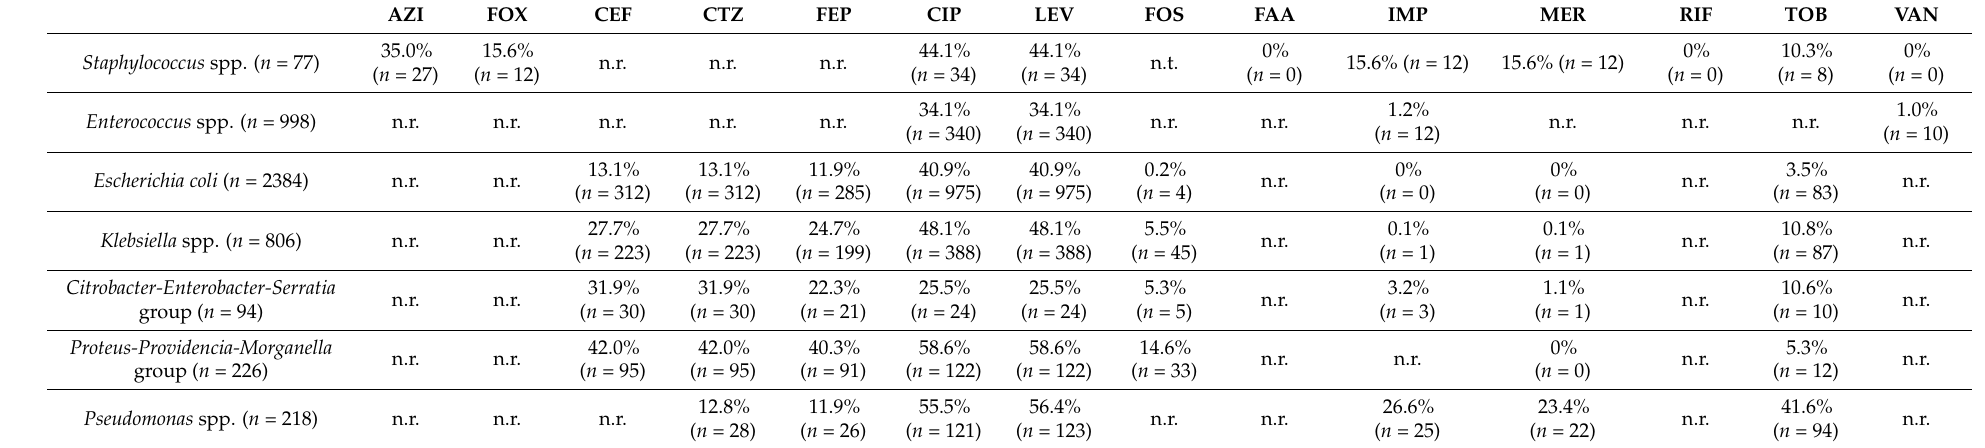
Table 6. Percentage of resistant isolates from outpatient UTIs against WHO Watch